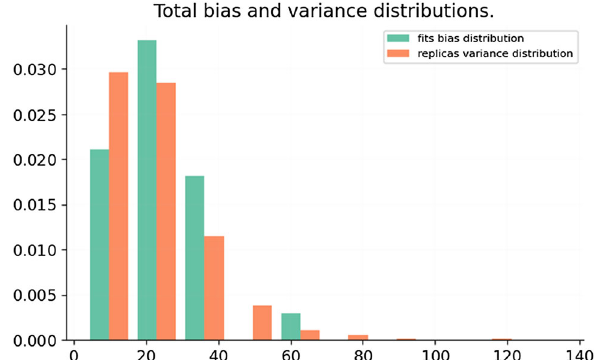
Fig. 8 The green histogram is the distribution of the total bias across fits, the orange histogram is the distribution of the difference between the replica and central predictions squared, in units of the covariance across all fits and replicas. In both of these cases, the x -axis represents the total distance in units of the covariance summed across all unseen data. We expect shape of the distributions to be equal, and qualitatively we see that this is approximately the case. We attribute difference in shape between the distributions to low statistics, in particular for the bias distribution across fits. For a qualitative comparison we compare the square root of the mean of each distribution shown here, getting the quoted value for R b v in Table 1, where we observe the first moment of the distributions are equal within